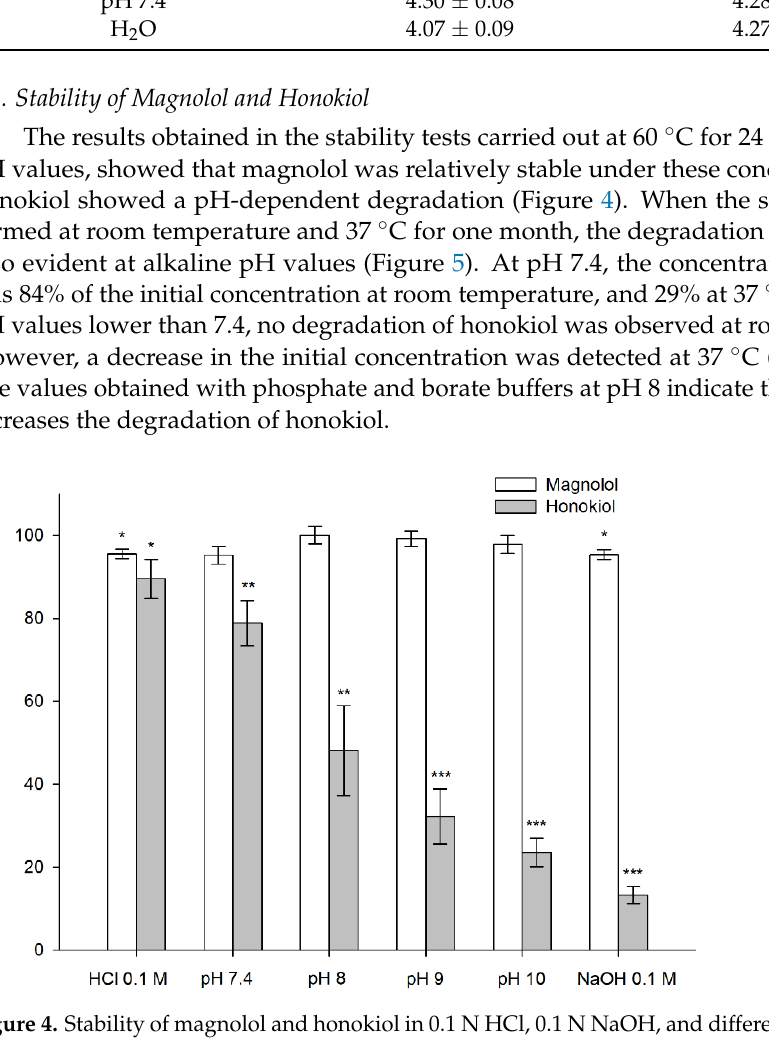
Table 2. Log D o/w values (mean ± SD, n = 4) of magnolol and honokiol determined using n-octanol (organic phase) and different pH buffers or water (aqueous phase).